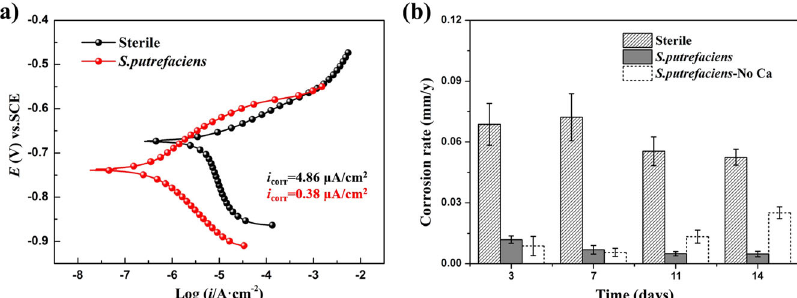
Fig. 7 Evaluation of microbiologically in fl uenced corrosion inhibition. a Potentiodynamic polarization curves; b corrosion rates of Q235 coupons in the sterile medium, in the S. putrefaciens -inoculated medium, and in the S. putrefaciens -inoculated medium without